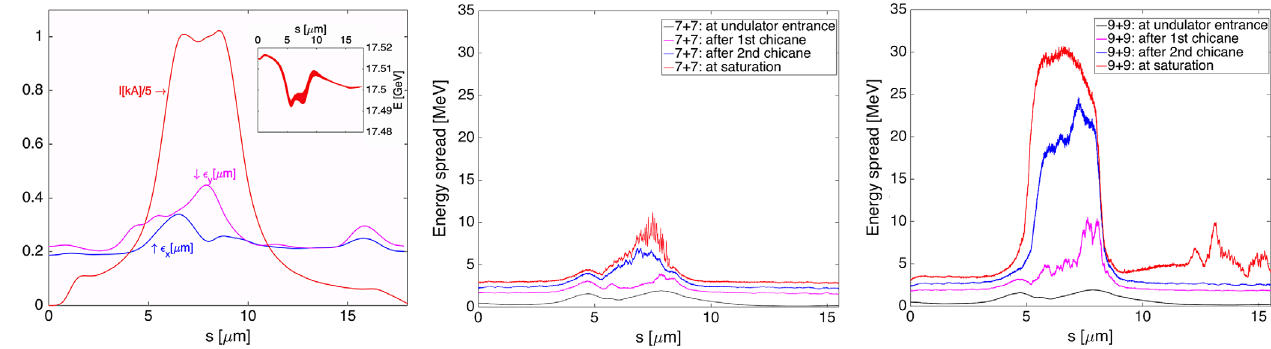
FIG. 8. Current, emittance and energy profile of an optimized electron beam distribution at 100 pC before the undulator (left) and energy spread profiles at different positions (see plot legend) for the 7 þ 7 (middle) and the 9 þ 9 (right) configurations. Energy spread profiles refer to the best events in Fig.